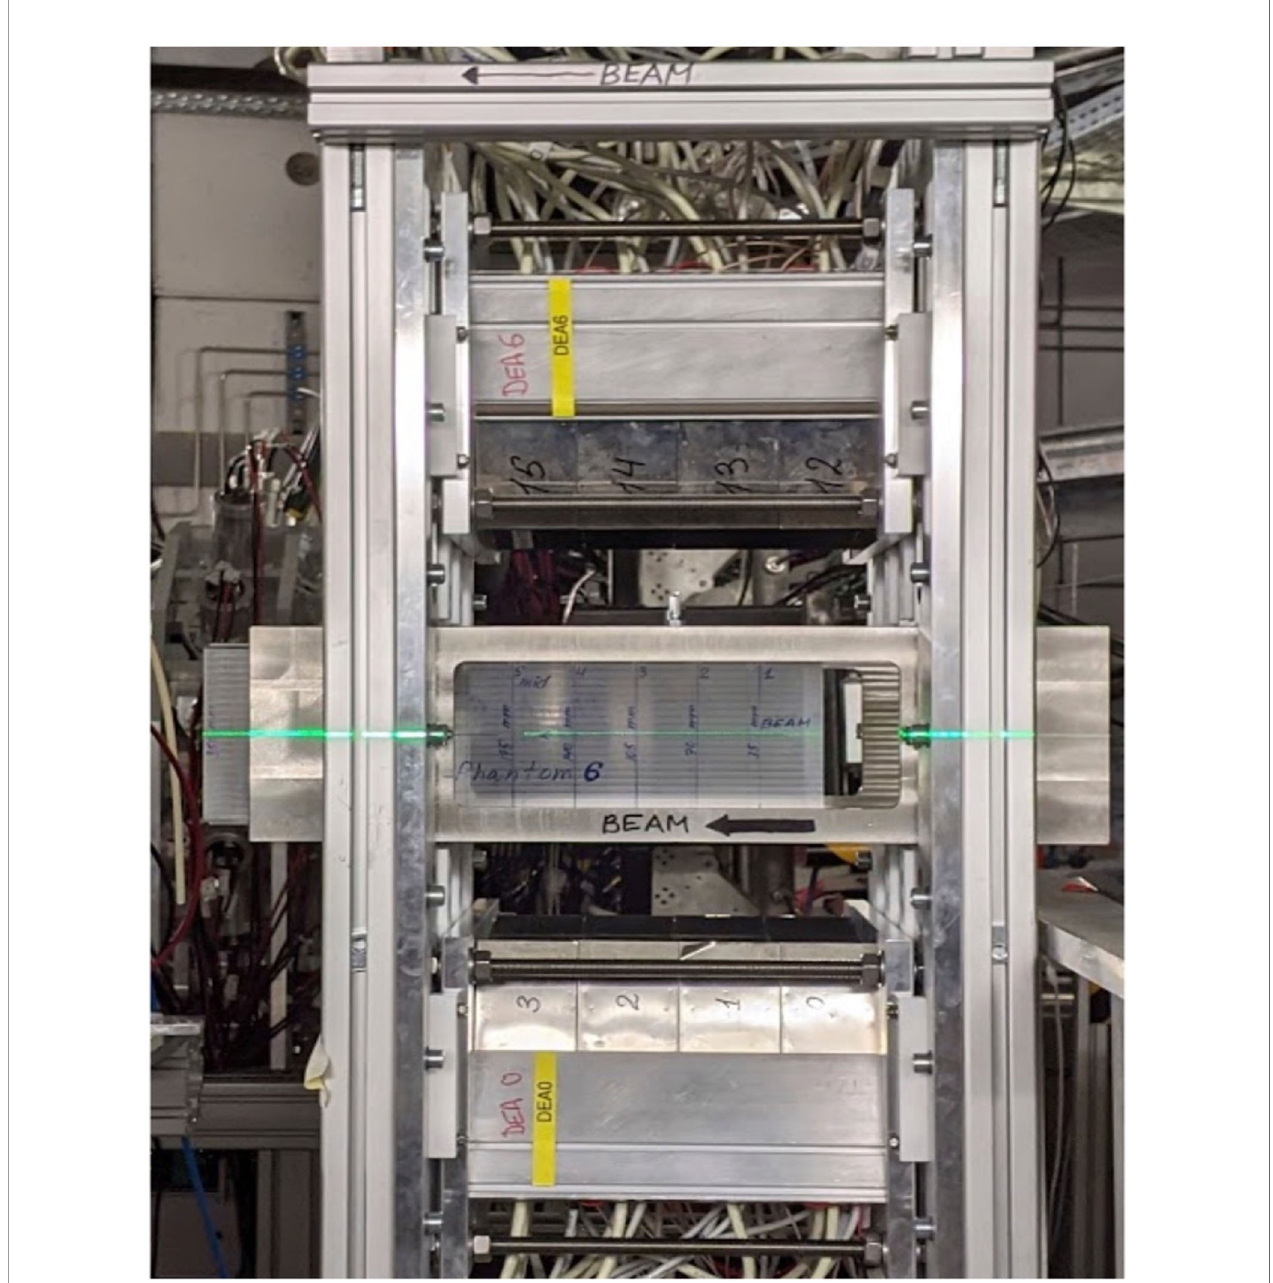
FIGURE 5 | The dual-panel UMCG positron imaging system installed at the Fragment Separator FRS at GSI. A beam of radioactive ions is coming from the right hand side and stopped in the PMMA phantom seen in the middle of the picture. The two detector panels are installed above and below the phantom each at a distance of 30